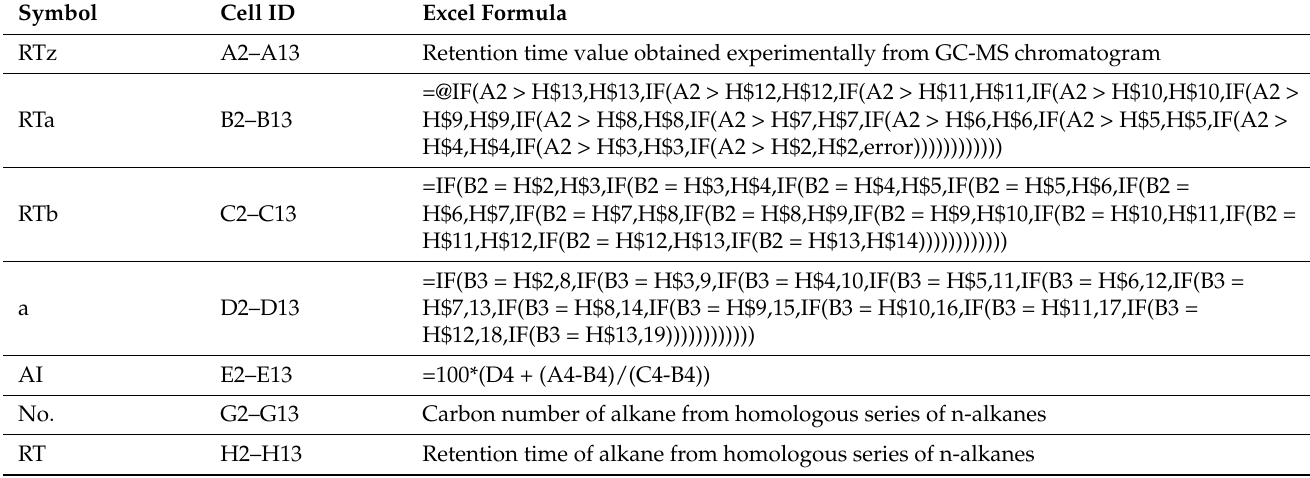
Table 2. Calculations used on the excel spreadsheet in Figure 20 for automatic calculation of arith- metic